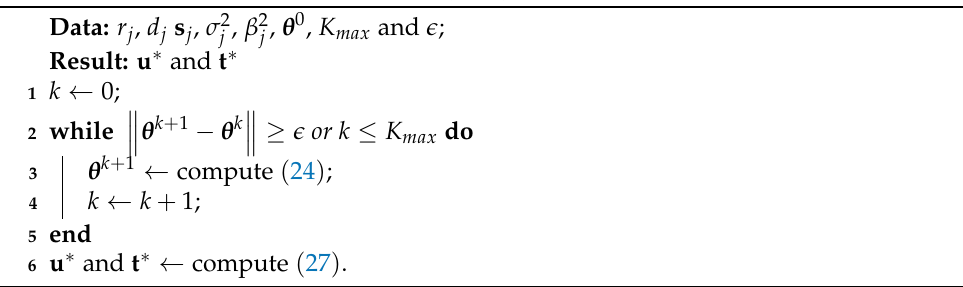
Algorithm 1: Elliptic Localization using single